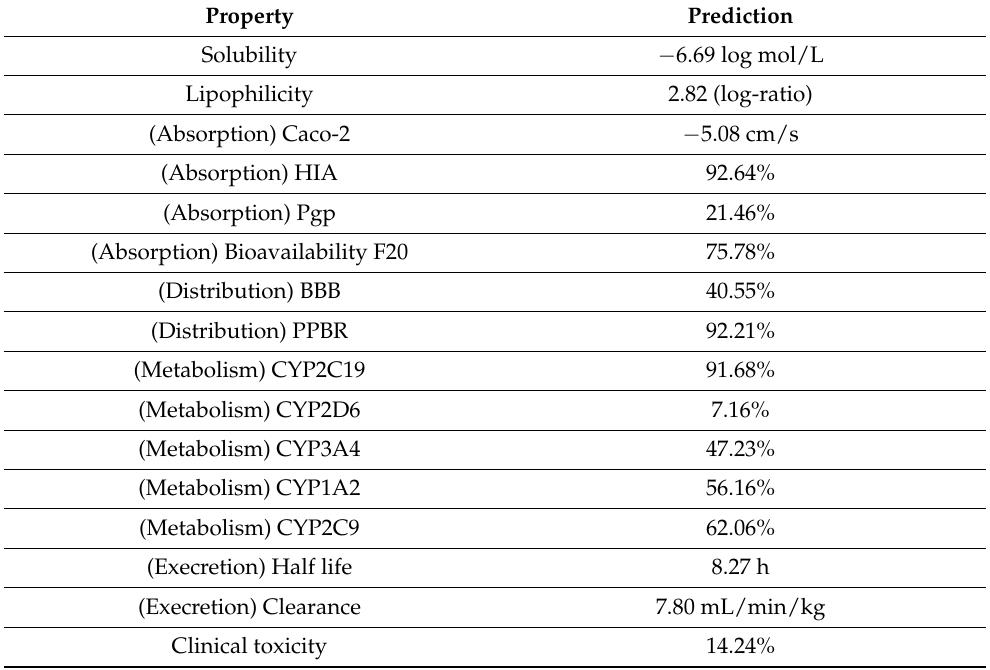
Table 6. ADME profile of compound 6e predicted via MPNN neural